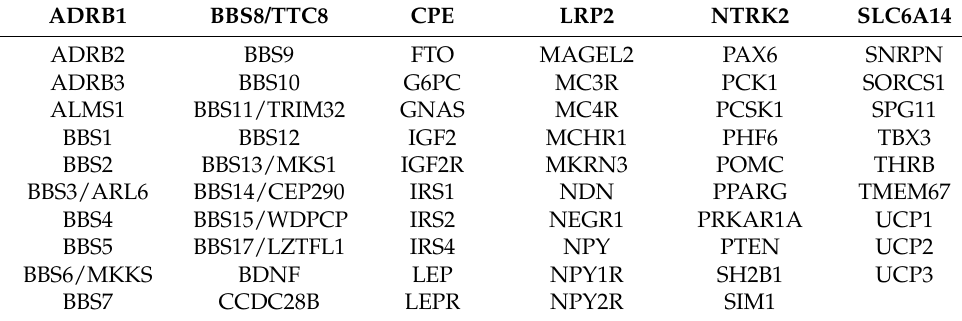
Table 1. Gene panel (genes previously associated with